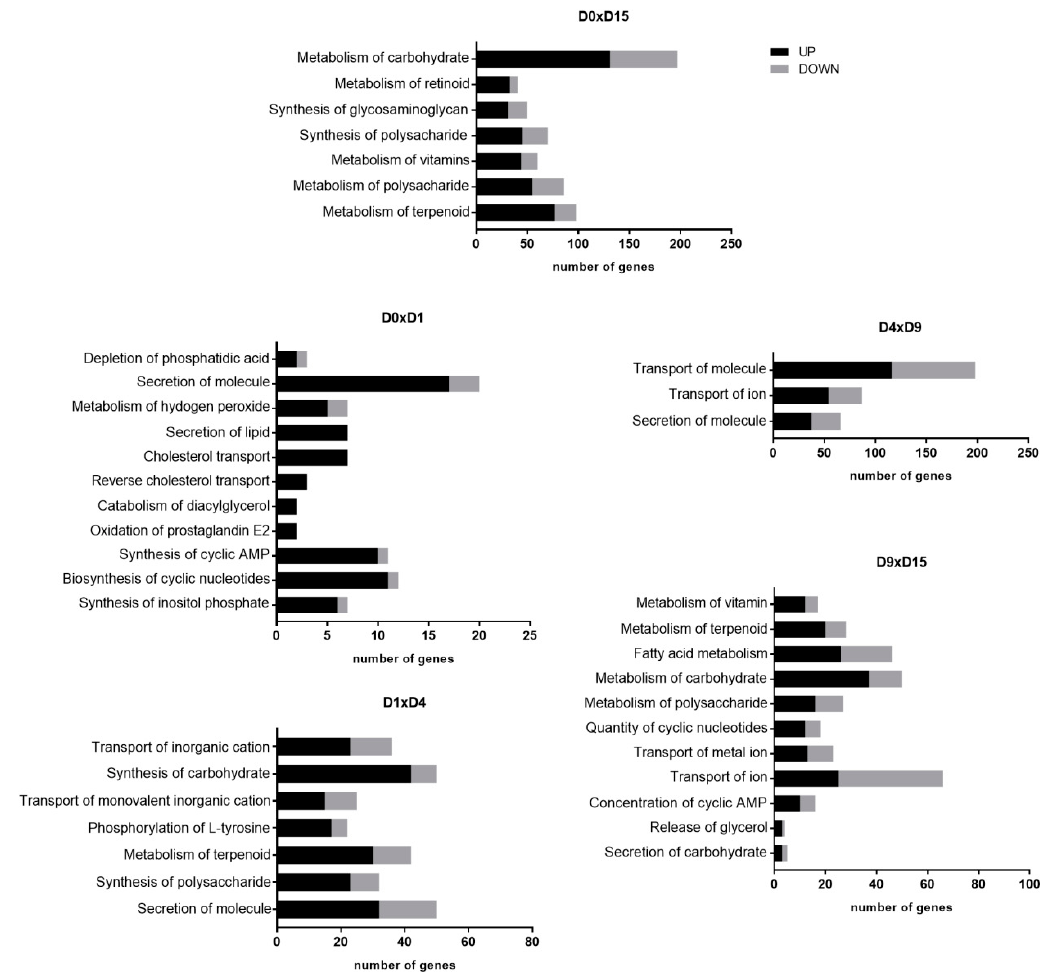
Figure 8. Biological functions related to metabolism enriched in in vitro cardiac differentiation. Graphs show the number of DEGs (up- and downregulated) identified based on the terms obtained from IPA at each cardiac differentiation transi- tion.